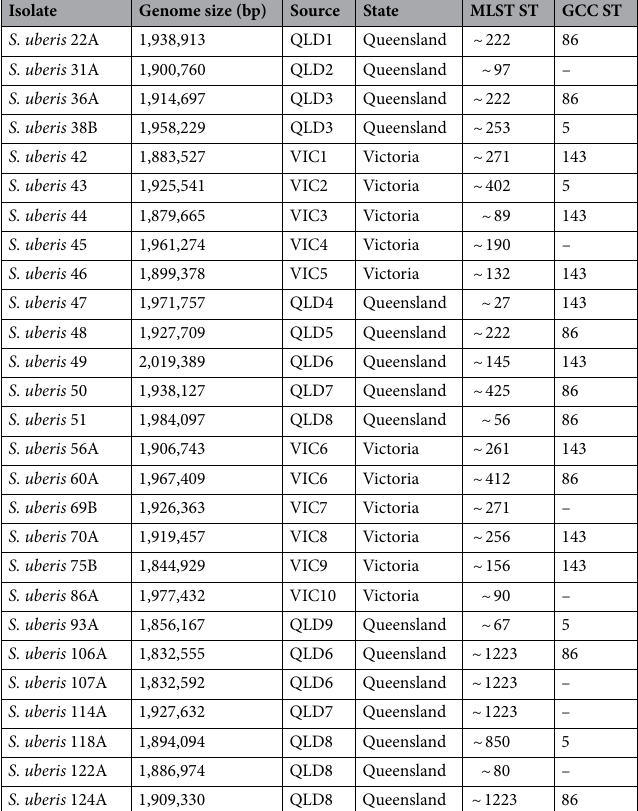
Table 1. Summary of S. uberis strains identified in this study, isolated from cows affected by bovine mastitis. MLST STs are also shown. ~ indicates closest ST. All STs were considered novel. The isolation sources have been given codes for privacy